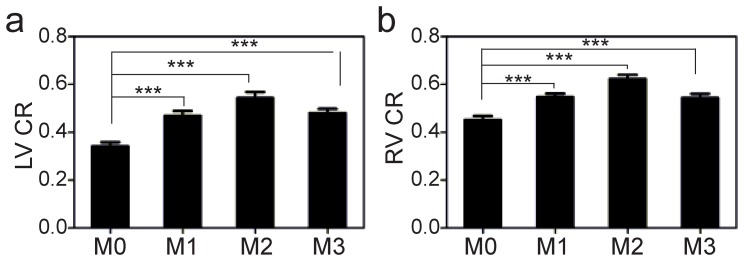
Image contrast at B-TFE cine imaging.Bar graphs showed CRs at LV-to-septum contrast (a) and RV-to-septum contrast (b) imaging with and without dual-source RF shimming. For CRs, the images with use of dual-source RF shimming (M1, M2, M3) revealed greater LV-to-septum and RV-to-septum versus the corresponding images with single-source mode. The CR of M2 was the largest with the FA = 58°. *** P<0.001 vs. single-source mode.